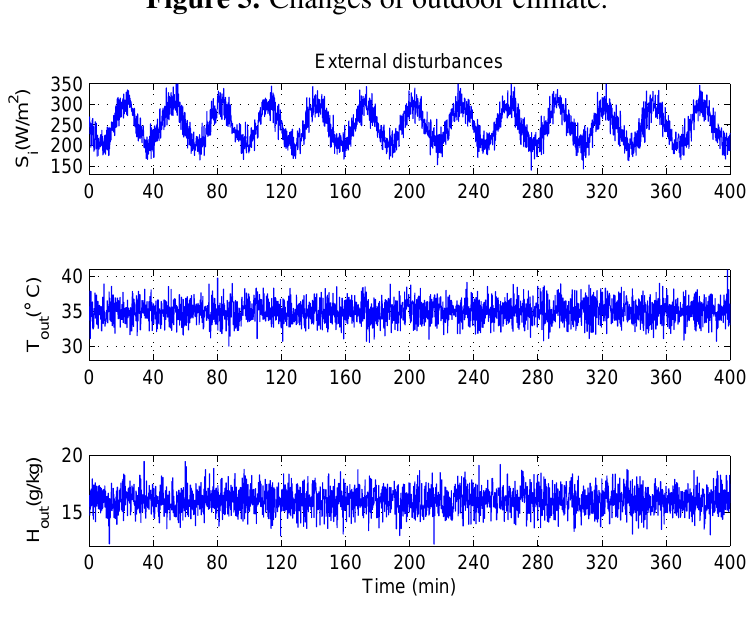
Figure 5. Changes of outdoor climate.